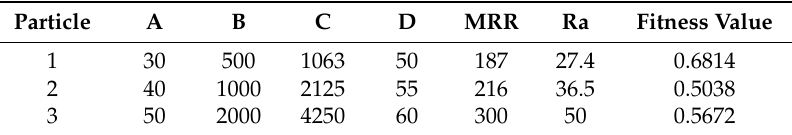
Table 6 . Initial Population and Fitness Value. Table 6. Initial Population and Fitness